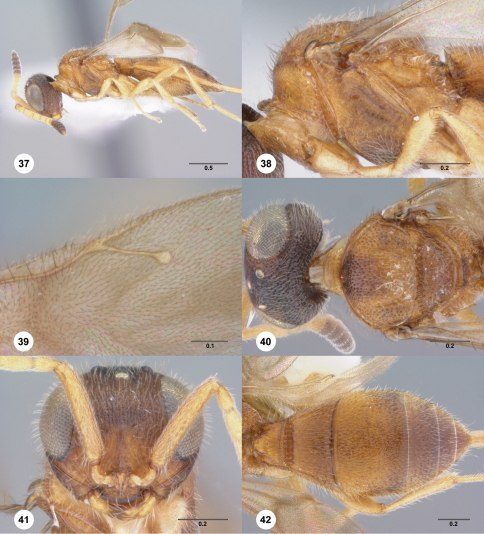
68Paridris kagemono sp. n., female holotype (OSUC 262193) 37 Lateral habitus38 Mesosoma, lateral view39 Forewing, dorsal view40 Head and mesosoma, dorsal view41 Head, anterior view42 Metasoma, dorsal view. Scale bars in millimeters.